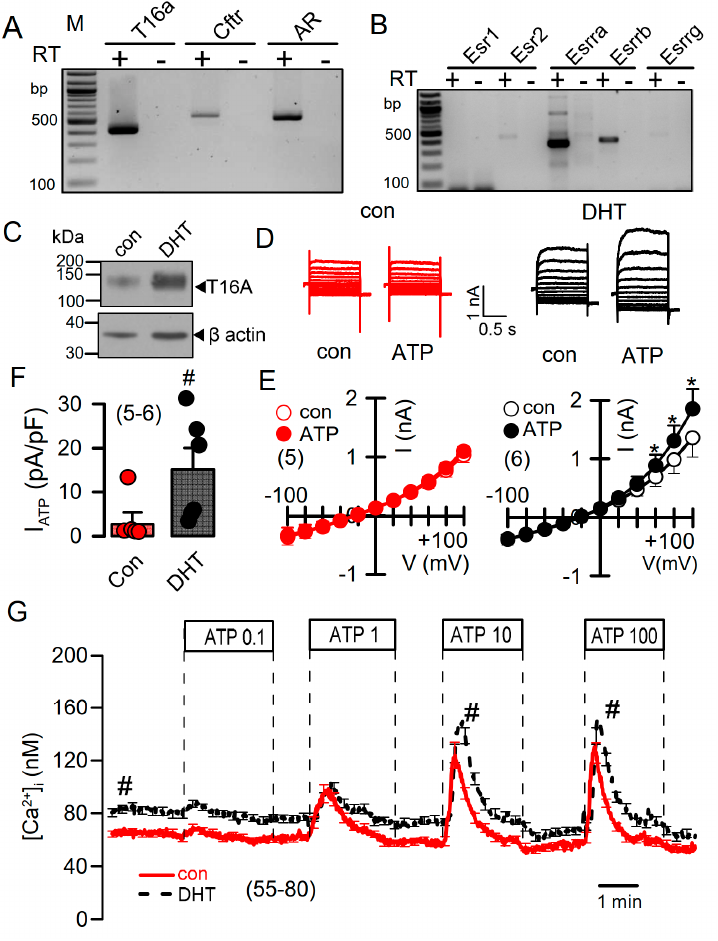
Figure 6. Effect of dihydrotestosterone on whole cell currents and intracellular Ca 2+ concentrations in mouse mCCDcl1 cortical collecting duct cells. ( A , B ) RT-PCR analysis of expression of Tmem16a, Cftr, androgen receptors ( A ), and estrogen receptors ( B ) in Pkd1 +/+ mCCDcl1 mouse collecting duct cells. ( C ) Western blot from mCCDcl1 cells, indicating upregulation of Tmem16a-expression by DHT. ( D , E ) Whole cell current overlays ( D ), corresponding I/V-curves ( E ), and summary of ATP (0.1 µ M) -activated whole cell currents ( F ) from mCCDcl1 cells, indicating larger basal and ATP-activated currents in DHT (10 µ M; 24 h) treated cells. Current densities (pA/pF) were assessed at the clamp voltage of +100 mV. ( G ) Basal and ATP (0.1–100 µ M)–induced increase in intracellular Ca 2+ concentration in control (con) and DHT-incubated mCCDcl1 cells. Mean ± SEM (number of experiments). * Significant activation by ATP ( p < 0.05; paired t-test). # Significant difference compared to con ( p < 0.05; unpaired